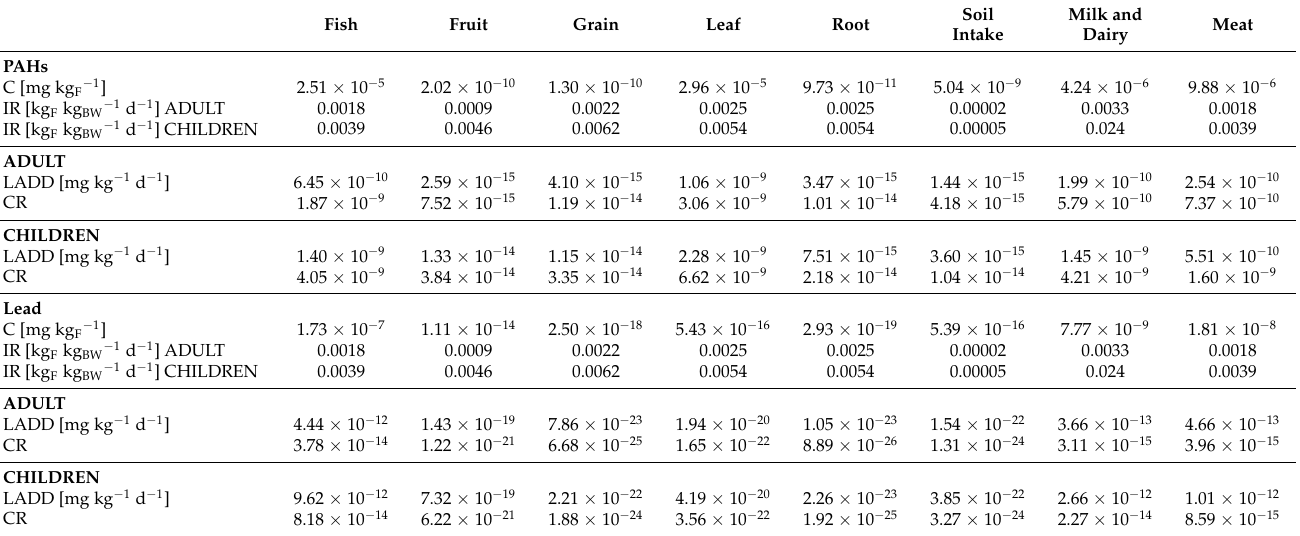
Table 9. Cancer Risk for PAHs and Lead from ingestion (soot emissions over the Italian law